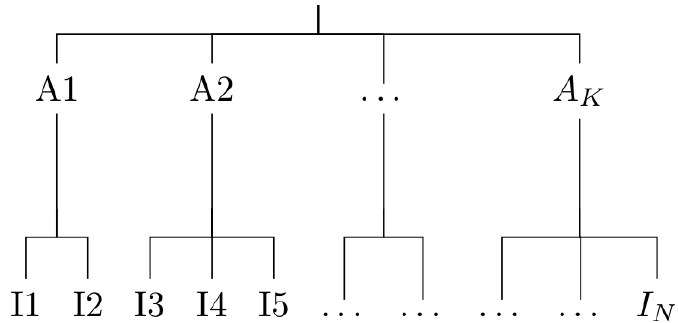
Figure 1. Schematic representation of a hierarchy of